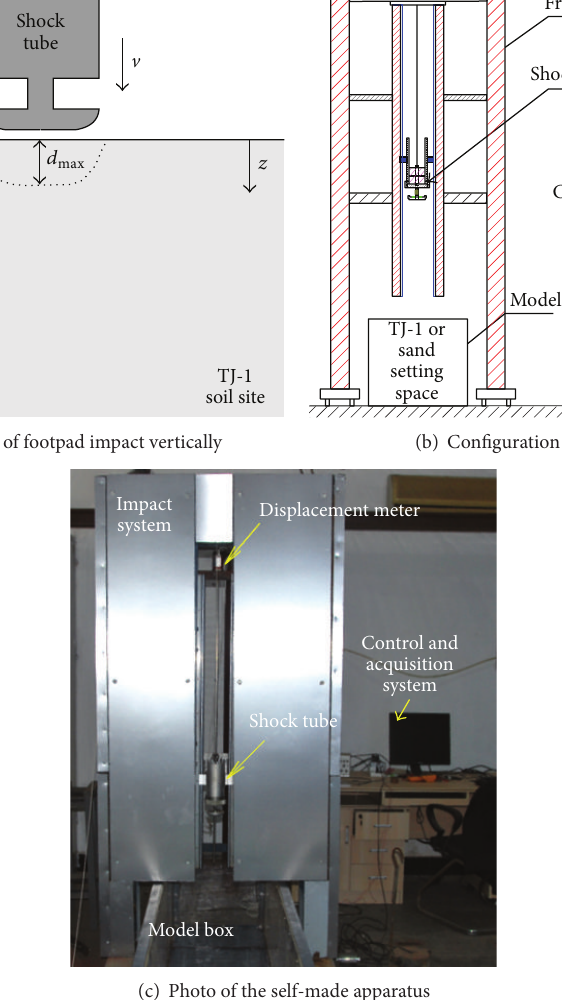
Figure 4: Impact model and test